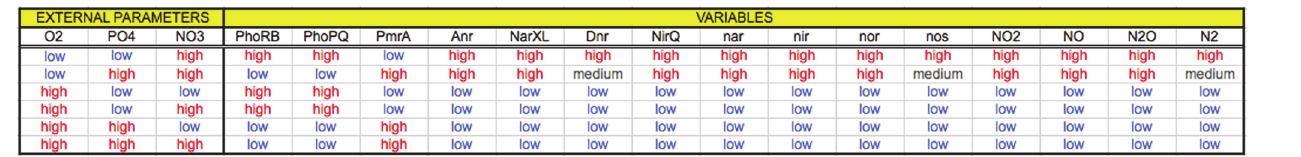
Fig 2. Steady states of the denitrification network under different environmental conditions. The first condition (low O 2 , low PO 4 and high NO 3 ) corresponds to the perfect condition for denitrification and the second condition (low O 2 , high PO 4 and high NO 3 ) corresponds to the denitrification condition disrupted by PO 4 availability. The remaining conditions can be labeled as aerobic conditions.